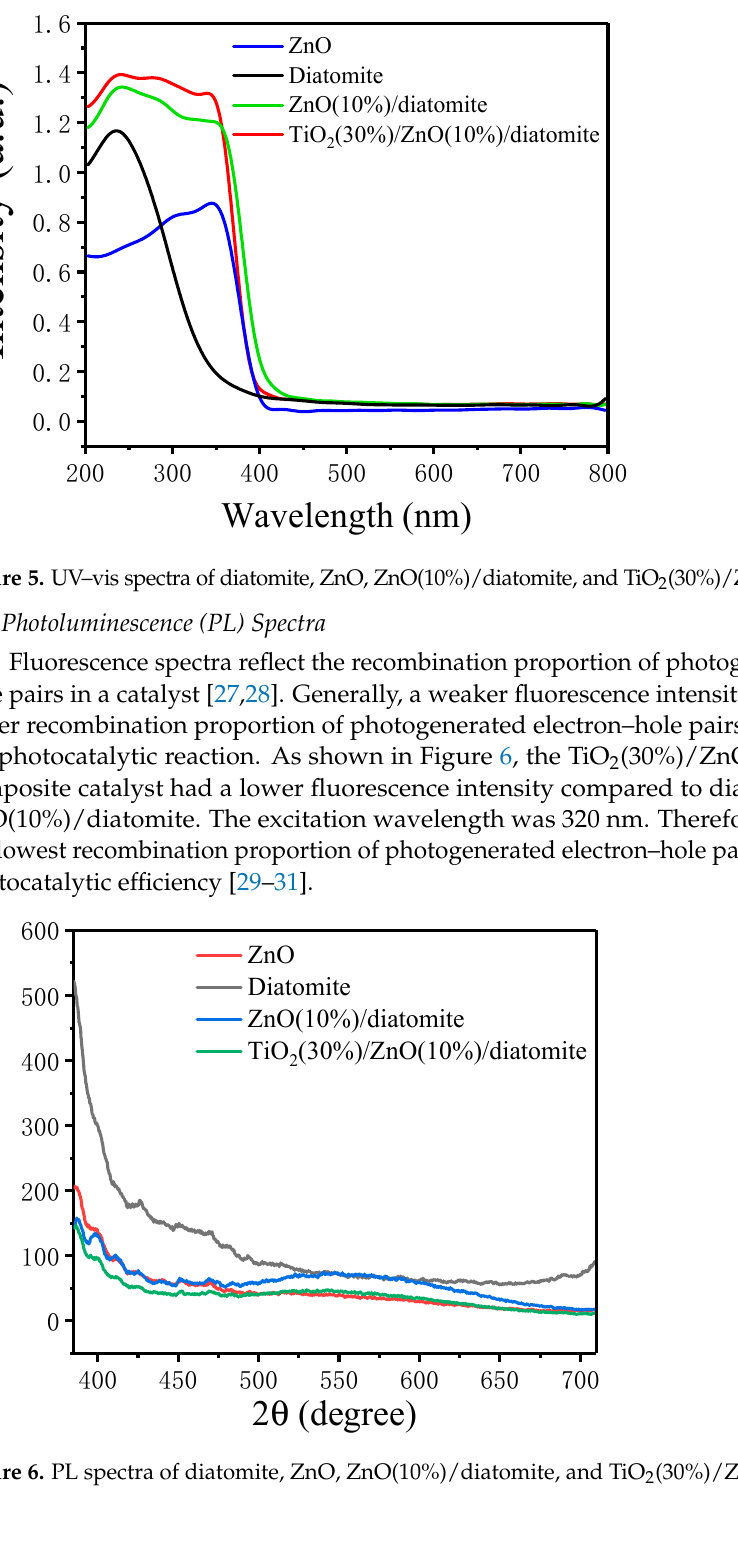
Table 1. Proportion of the three oxygen species of ZnO, ZnO(10%)/diatomite, and TiO 2 (30%)/ZnO(10%)/diatomite.